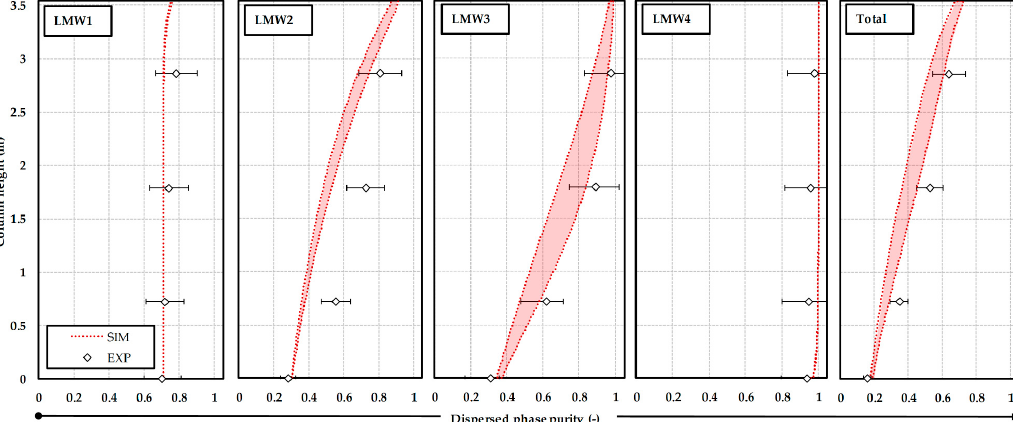
Figure 11. Comparison of experimental and simulated purity profiles of the wash extraction.